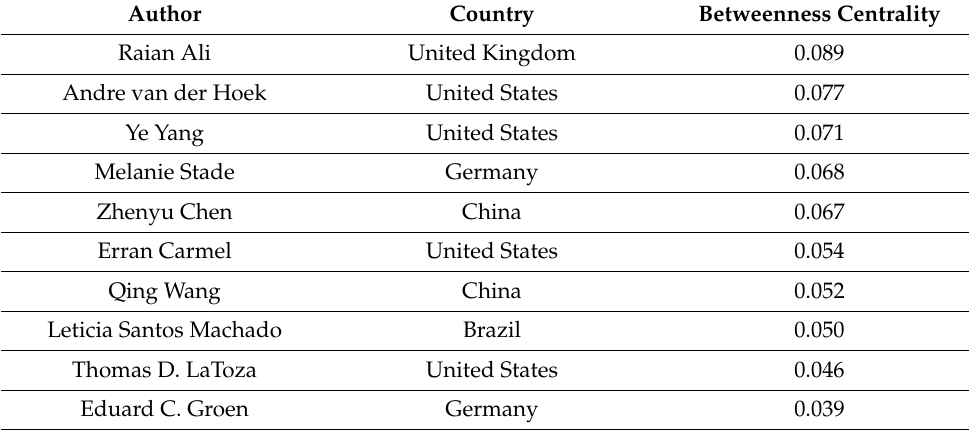
Table 7. Betweenness centrality of authors in the CSE co-authorship network.